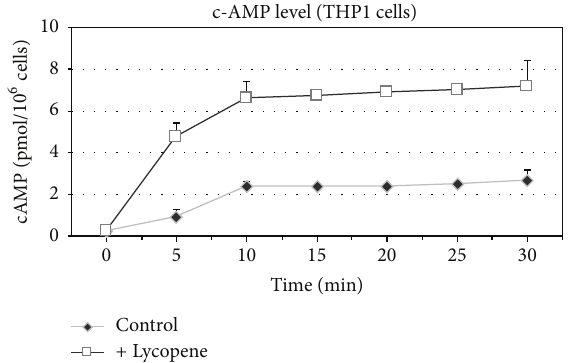
c-AMP level (THP1 cells)